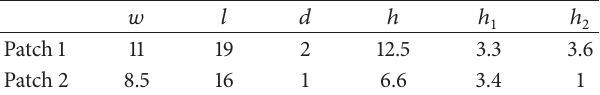
Table 1: The sizes of array antenna (unit: mm).